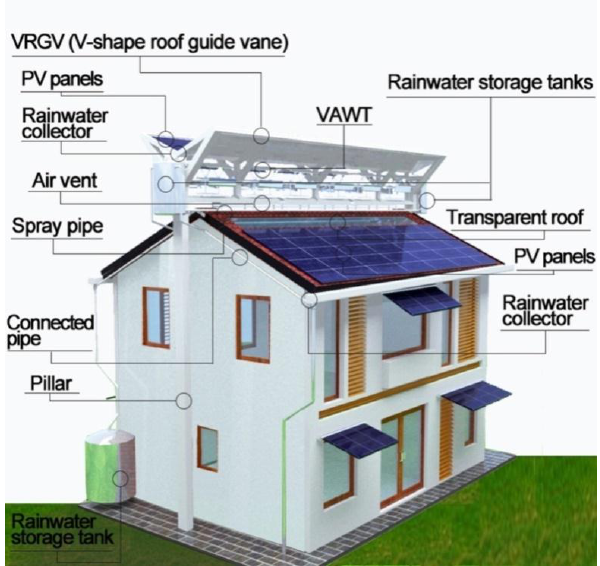
Figure 3. Artistic expression of an eco-roof system with V-shape roof guide vane (VRGV) for a building.